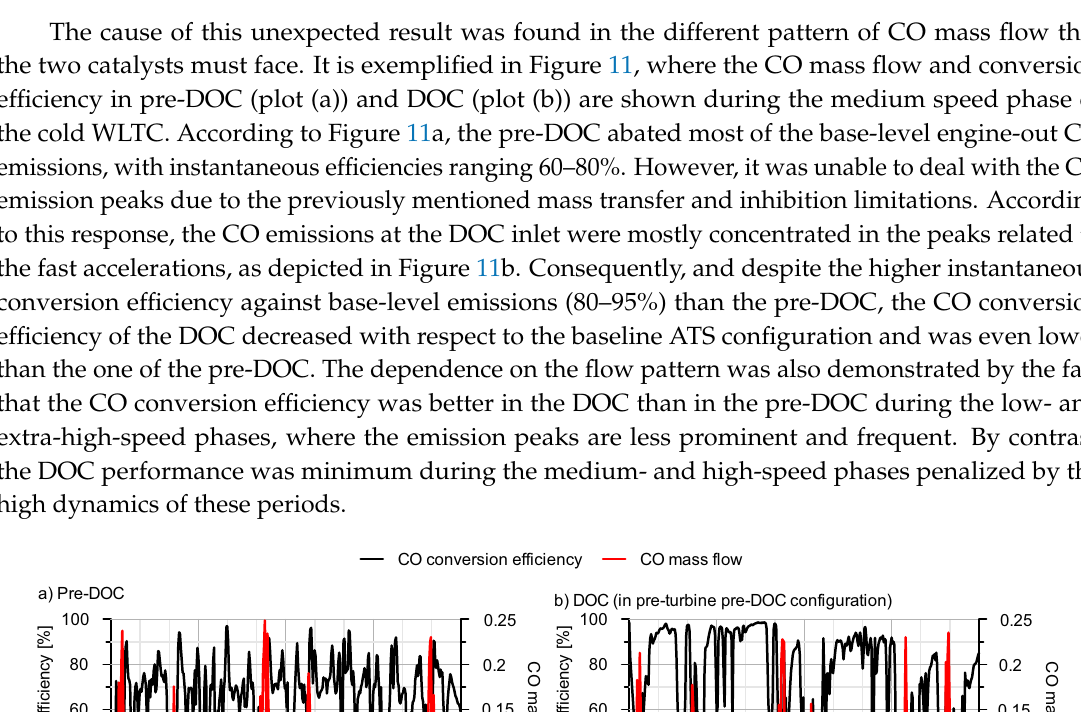
Figure 10. CO conversion efficiency in each WLTC phase in ( a ) cold and ( b ) warm tests: baseline (DOC) and pre-turbine pre-DOC (overall and contributions from pre-DOC and DOC) configurations.